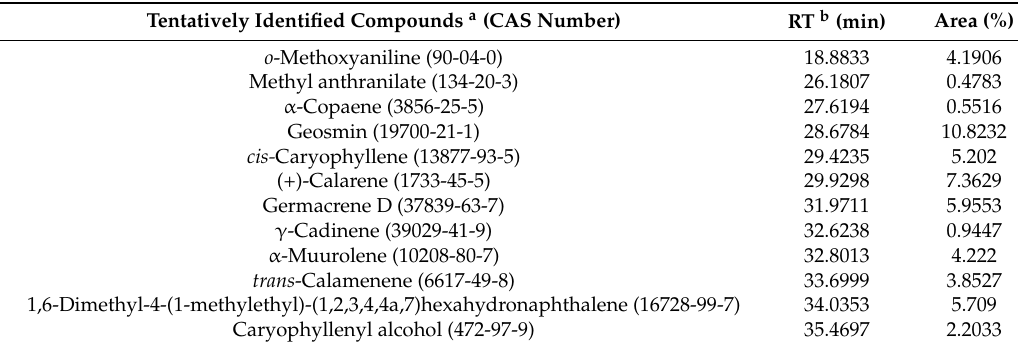
Table 2. Volatile compounds identified from 14 d culture of S. fimicarius BWL-H1.